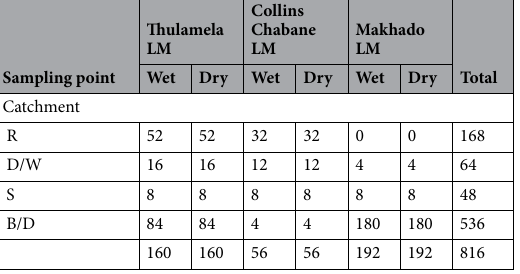
Table 6. Samples collected in wet and dry season. LM local municipality, R river, D/W dam or weir, S spring, B/D borehole or hand-dug well.